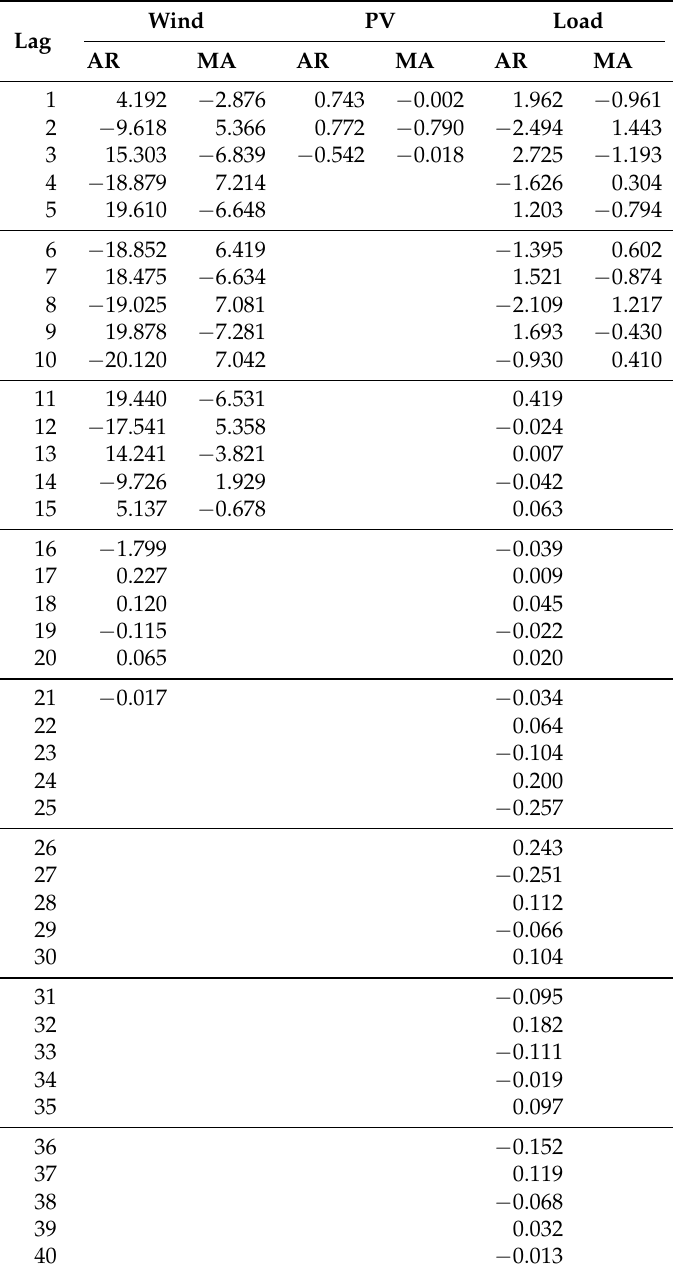
Table A1. Parameter for ARMA models for wind, pv, and load.